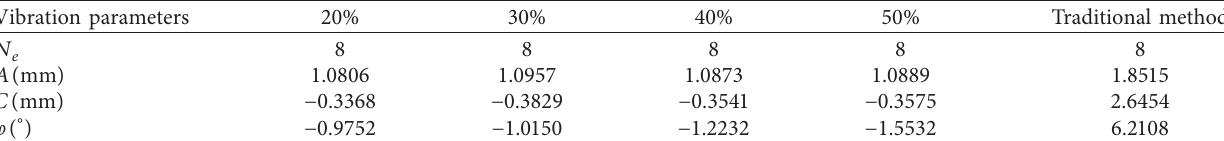
Table 2: Parameter identification results of No. 0